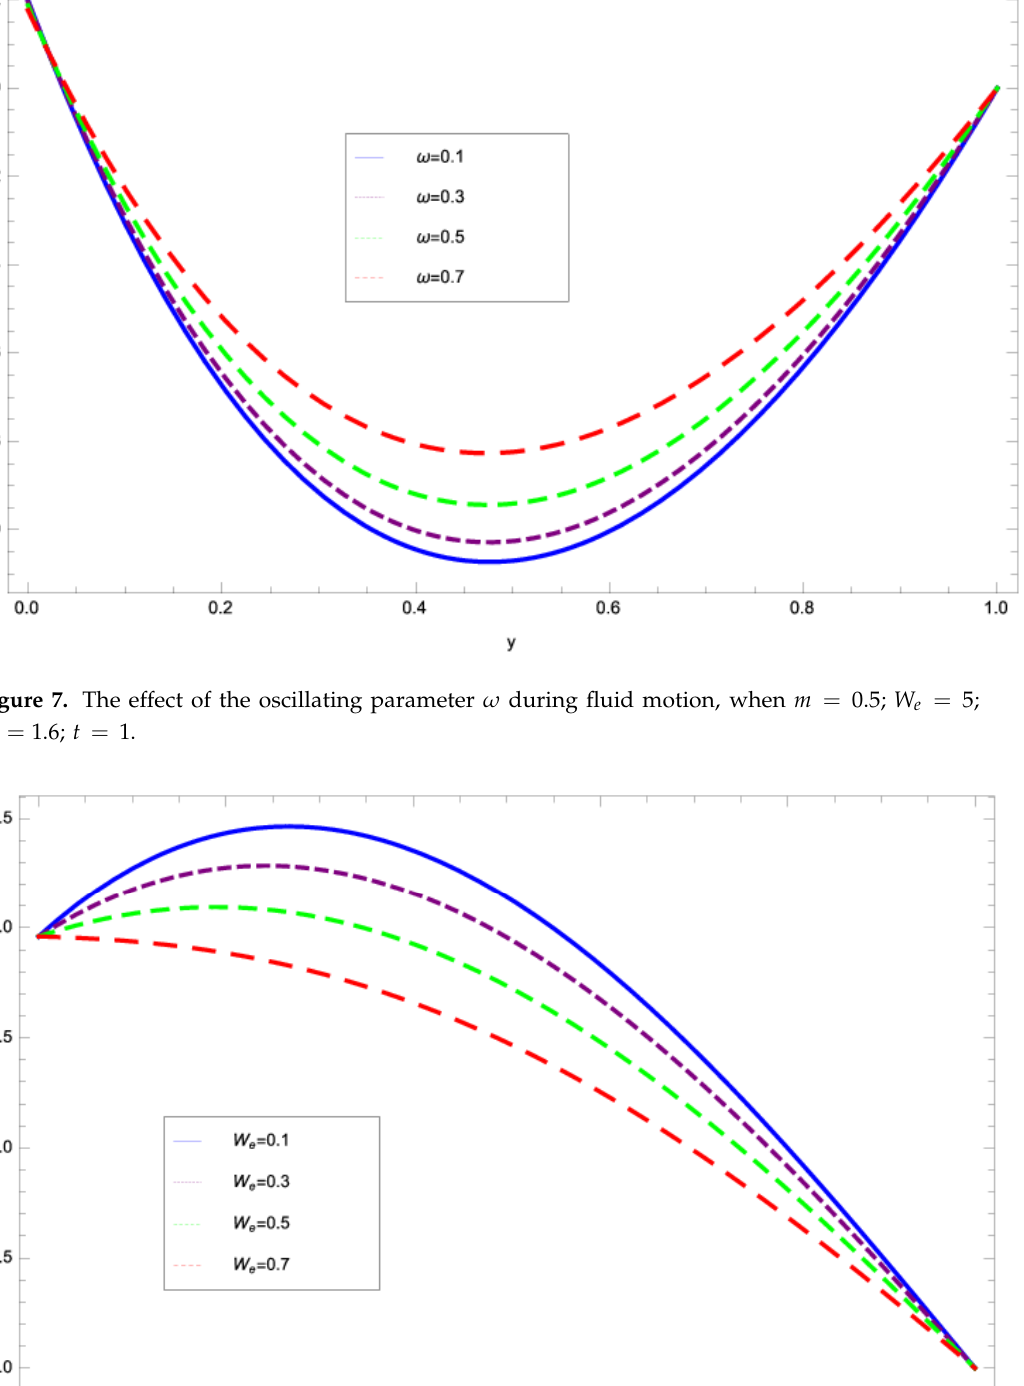
Figure 6. The magnetic effect during fluid motion, when.